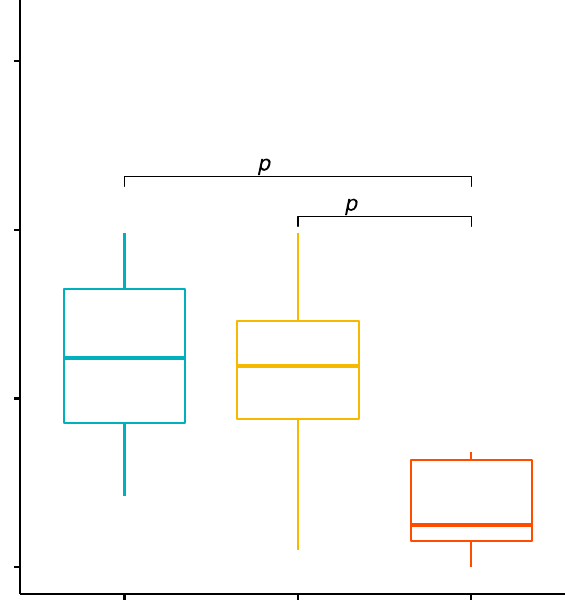
Figure 5. Percentage of CD4+/TLR-4+ T lymphocytes (among CD4+ cells; %) in patients with GD before treatment, after euthyroidism and in the control group.